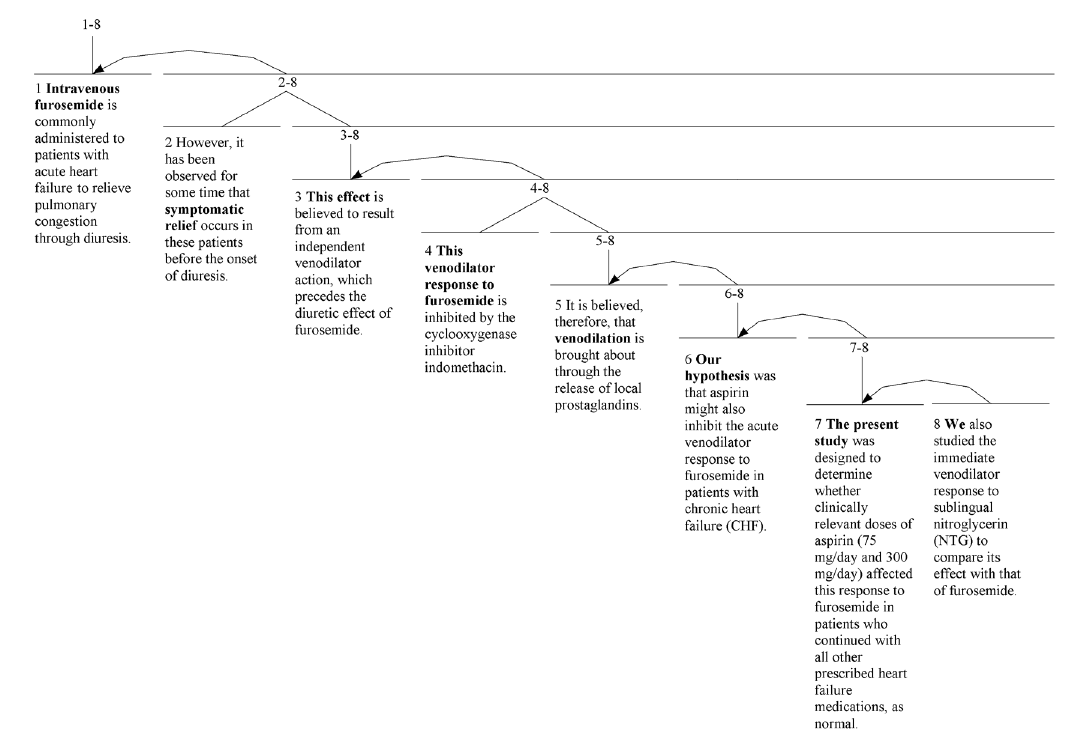
Figure 1. Rhetorical diagram of the English